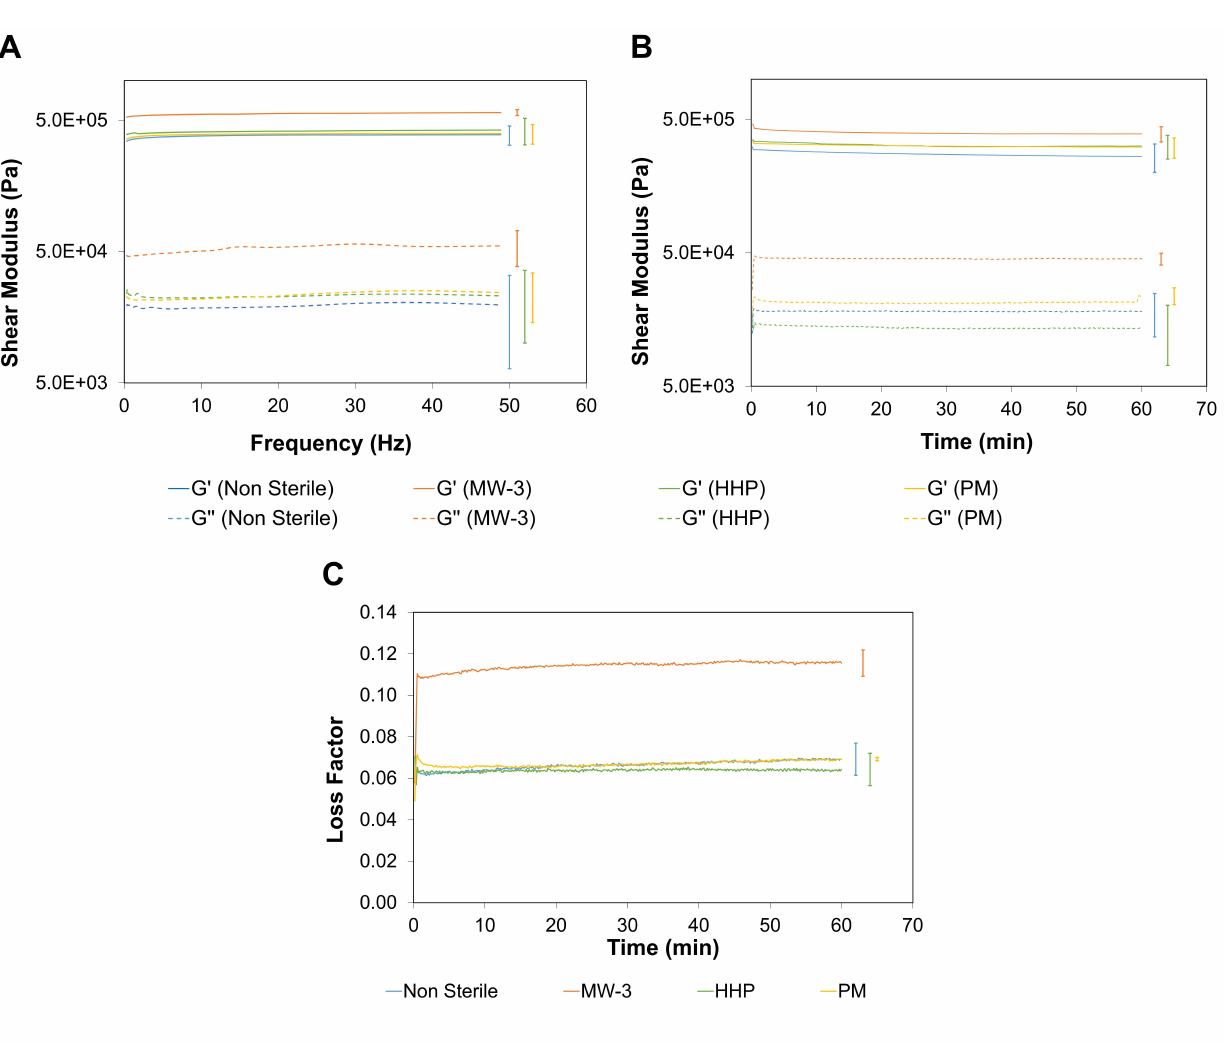
Figure 7. Storage (G (cid:48) ) and loss (G”) moduli for non-sterile and sterile PVA/PBO hydrogels ( A ) as a function of the frequency (0.1–50 Hz) and ( B ) of time (1 h) with a frequency of 1 Hz, both at a fixed strain rate γ = 0.1%. Loss factor variation with time ( C ). The error bars are the ± standard deviation ( n =